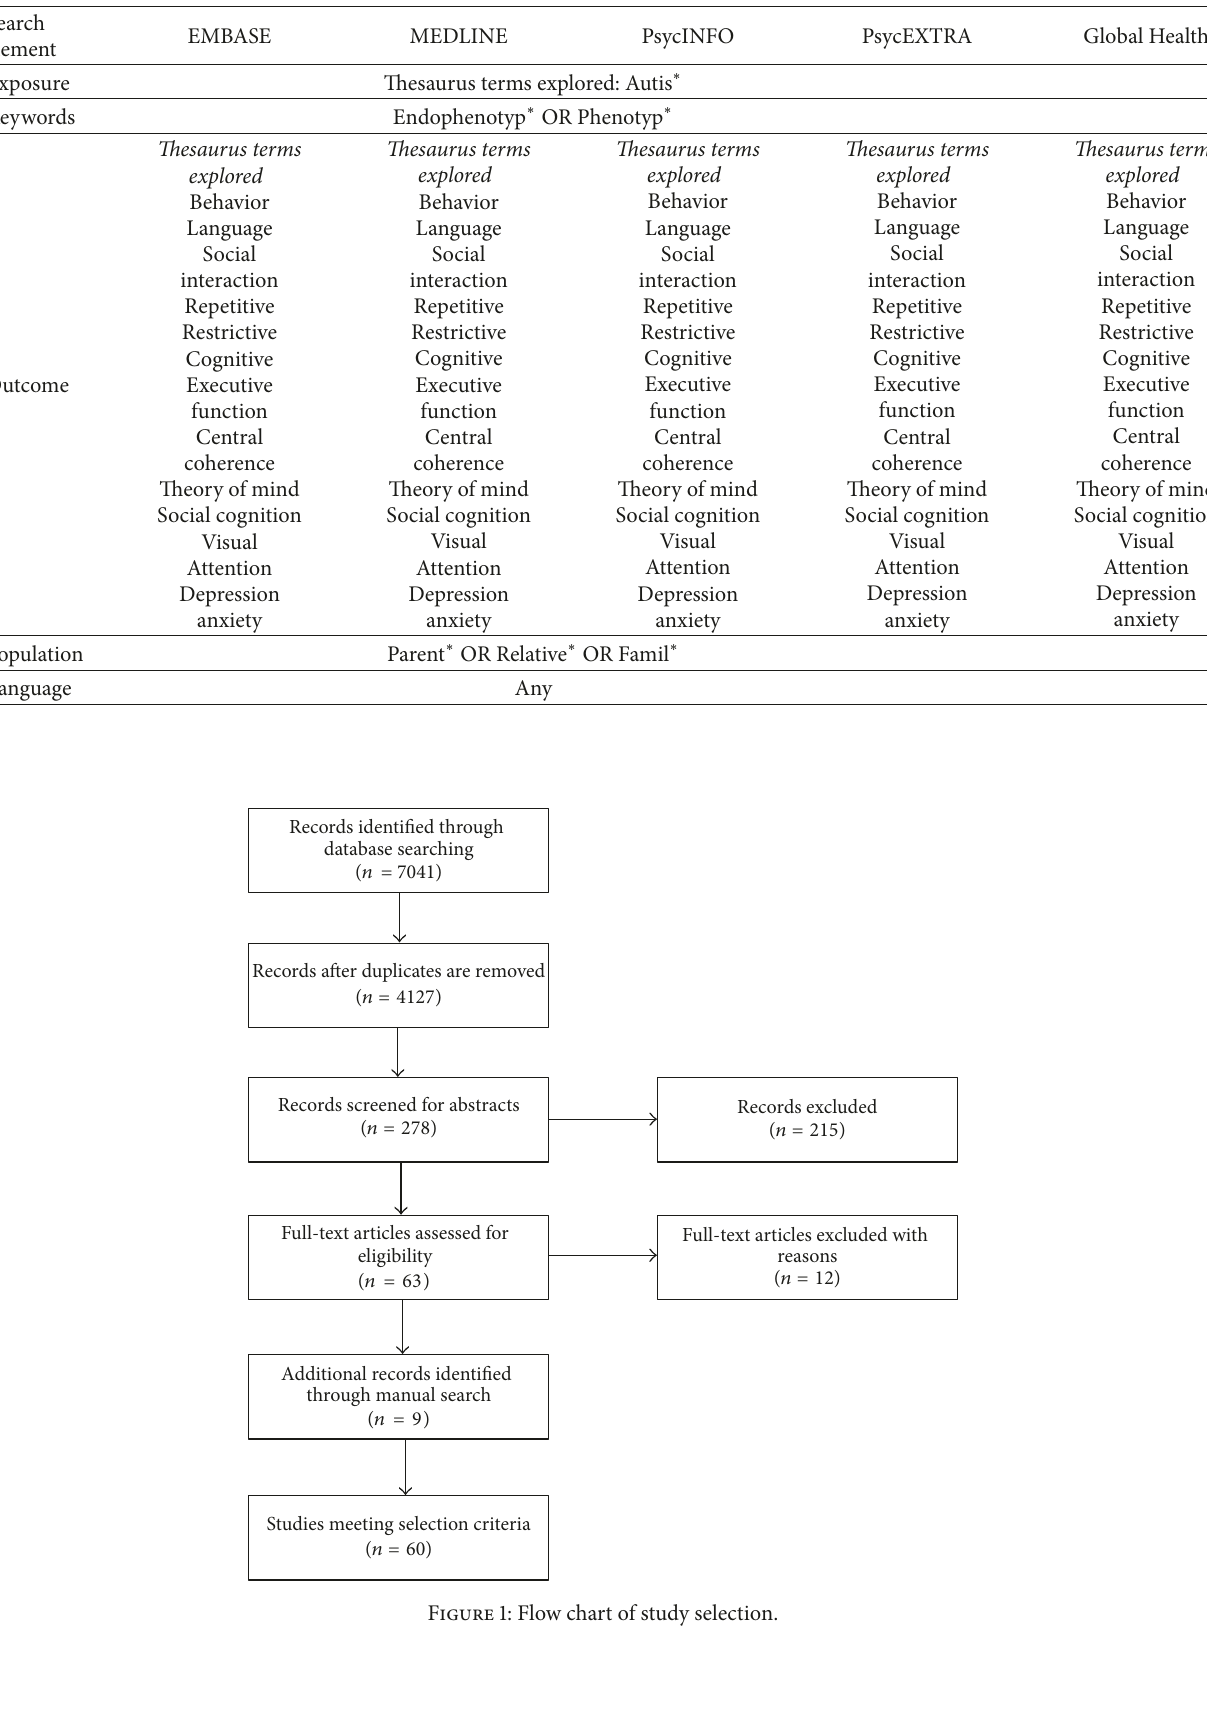
Table 1: Description of search strategy.